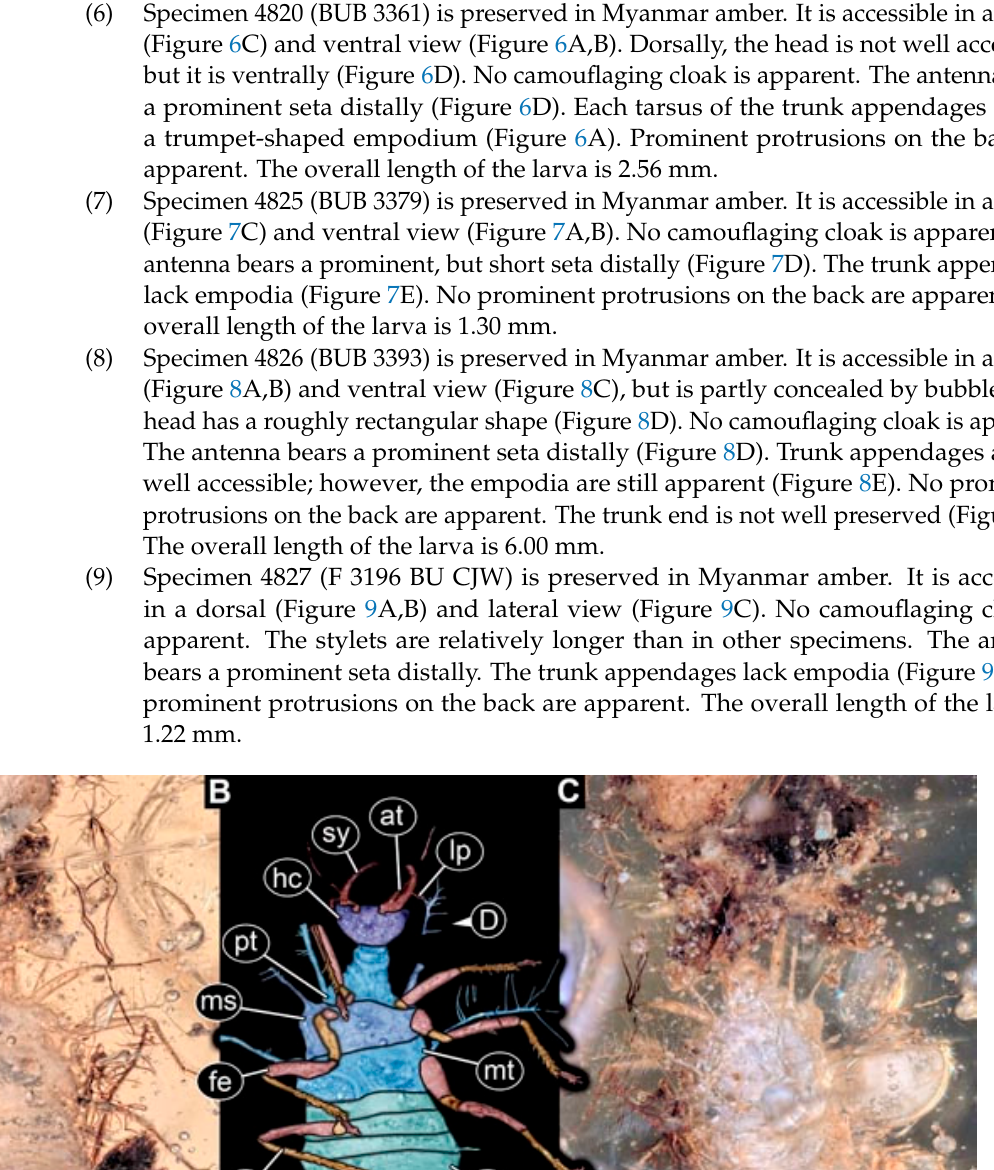
Figure 7. Specimen 4825 (BUB 3379); Myanmar amber. ( A ) Ventral view. ( B ) Ventral view, colour- marked. ( C ) Dorsal view. ( D ) Close-up of head capsule in ventral view. ( E ) Close-up of distal end of trunk appendage. Abbreviations: a2–a6 = abdomen segments 2–6; at = antenna; fe = femur; hc = head capsule; sy = stylet; ta = tarsus; th = thorax; ti = tibia.